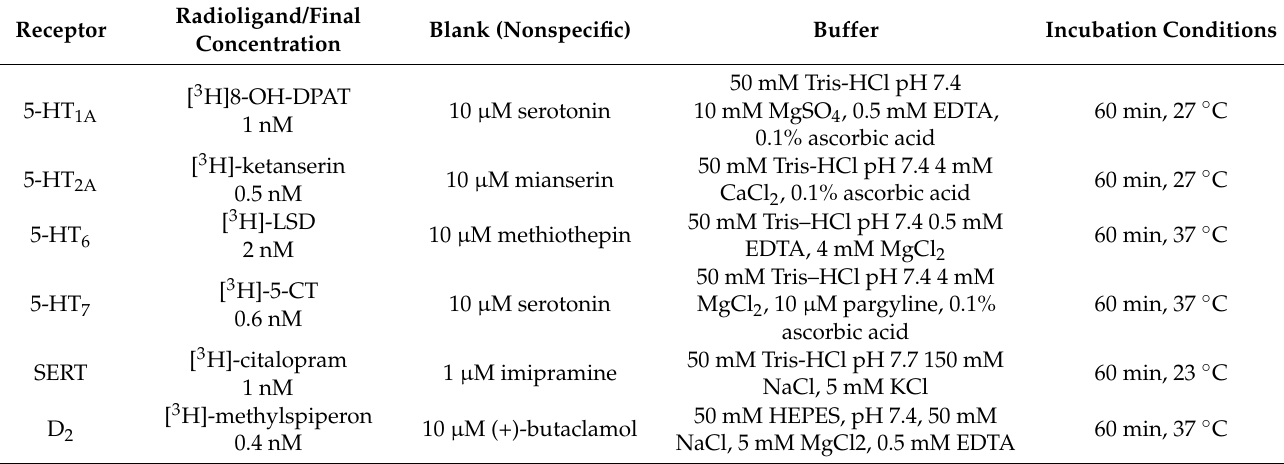
Table 9. Radioligand binding assays